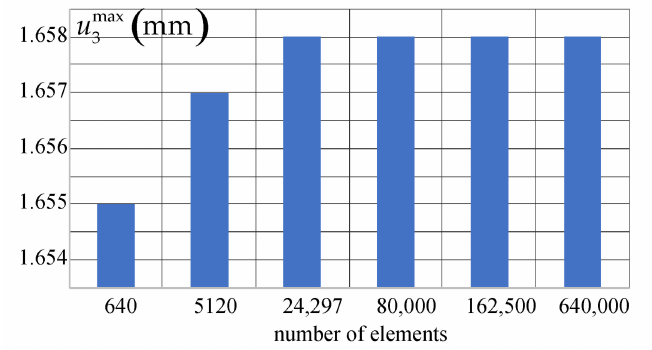
Figure 14. Mesh sensitivity in the FEM solution of the rod problem.